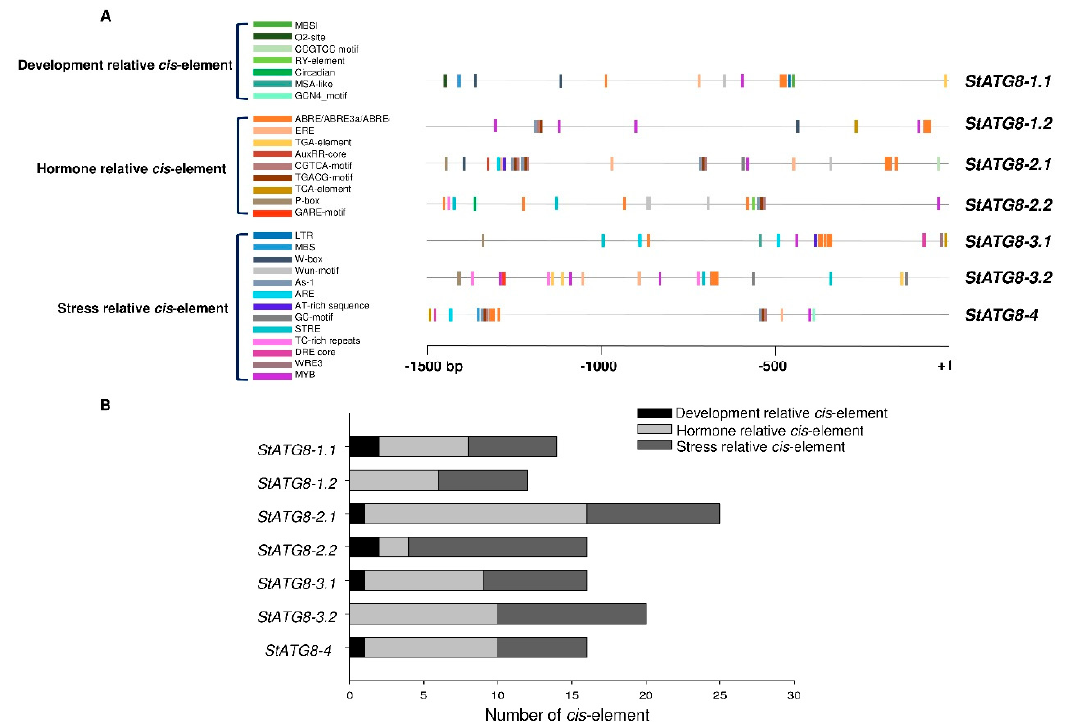
Figure 2. Promoter analysis of StATG8 family. (A). The 1.5 kb genomic DNA sequence upstream of the initiation codon of each StATG was retrieved from the S . tuberosum genome (http://spuddb.uga.edu/index.shtml) on 1 to 20 February 2022. The cis -elements of StATG8 promoter were predicted using PlantCARE (http://bioinformatics.psb.ugent.be/webtools/plantcare/html/) on 1 to 20 February 2022. (B). The cis -element present in StATG8 is divided into three categories related to development, hormone, and stress. It was summarized in a graph.